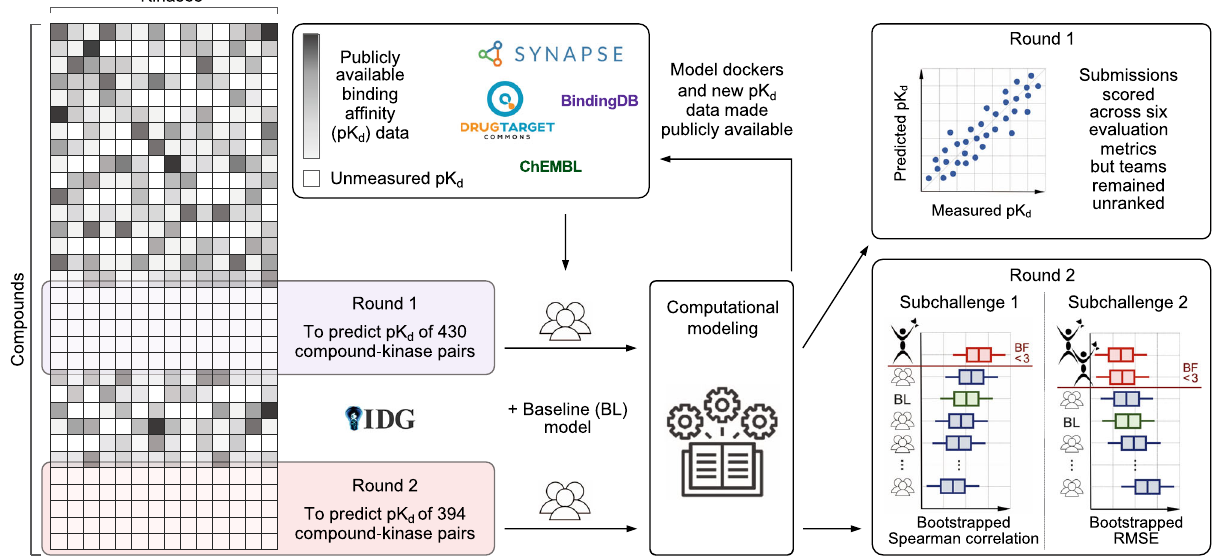
Fig. 1 Implementation of the IDG-DREAM Drug-Kinase Binding prediction Challenge. The participants had access to publicly available large-scale target pro fi ling training data, and the quantitative predictions from regression models were then validated in two unpublished and blinded test datasets pro fi led by the Illuminating the Druggable Genome (IDG) program (Round 1 and Round 2 datasets). Heatmap on the left is for illustrative purposes only (see Supplementary Fig. 2 for the actual test data matrices, and Supplementary Fig. 3 for the Challenge timeline). All the models, new bioactivity data, and benchmarking infrastructure are openly available to support future target prediction and benchmarking studies. BF Bayes factor; RMSE Root Mean Square